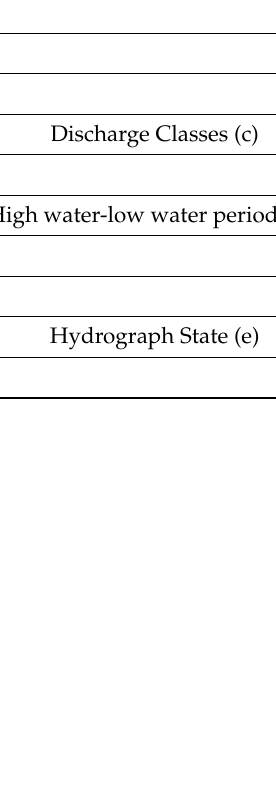
Table 5. Evaluation of various SRC models during the testing